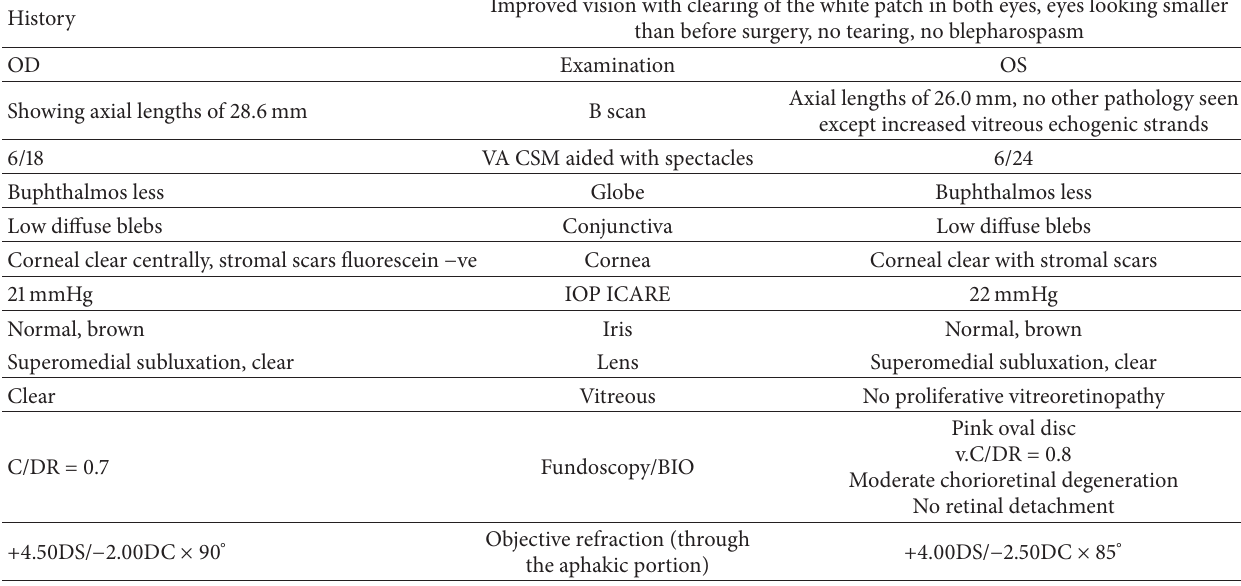
Table 6: Eight weeks after combined trabeculotomy + trabeculectomy 5FU and left delayed suprachoroidal drainage in clinic.